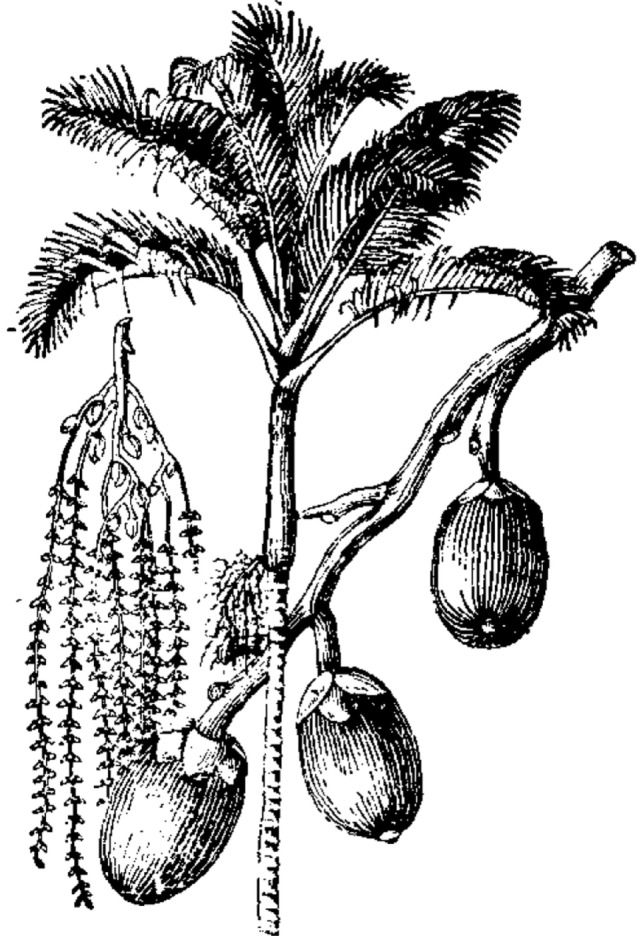
A diagrammatic illustration of betel nut. Betel nut is obtained from the betel catechu tree. Source: Iconographia cormophytorum sinicorum Tomus Ⅴ (1976) page: 356 (In Chinese).